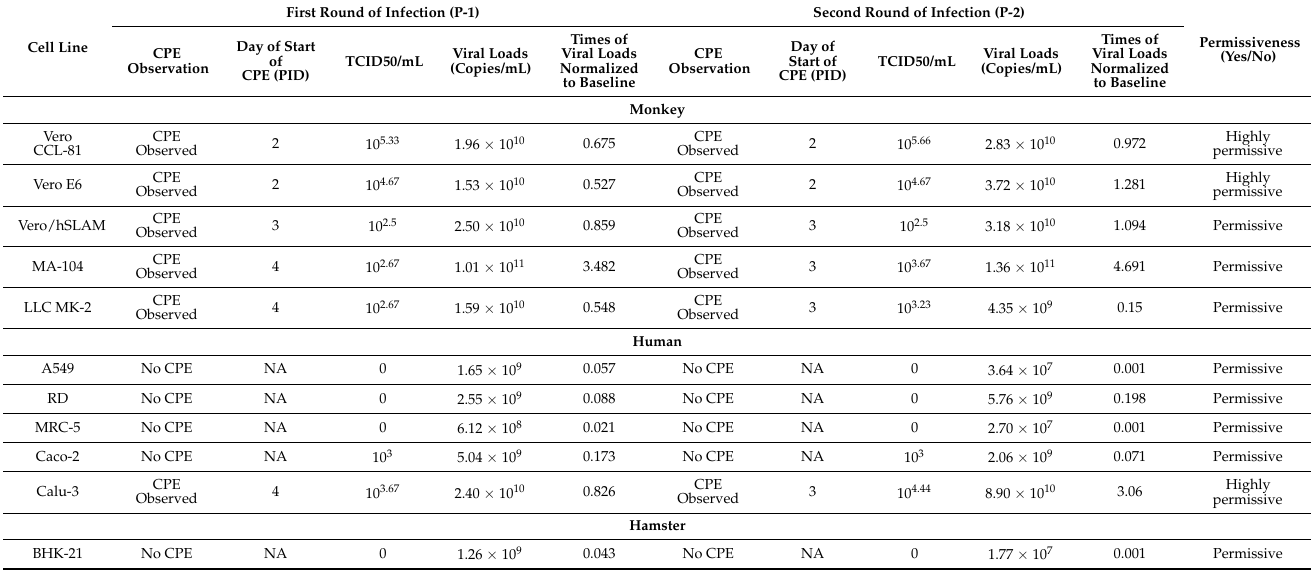
Table 3. Cell lines tested for SARS-CoV-2 Omicron BA.1.1 variant infection